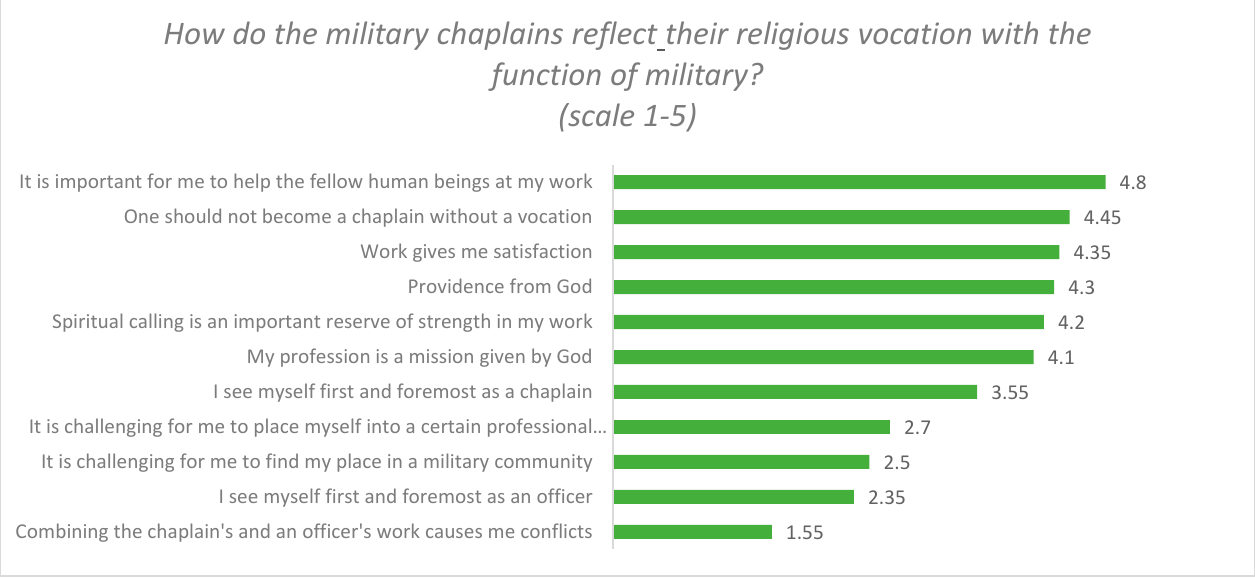
Figure 6. How do the military chaplains reflect their religious vocation with the function of military?